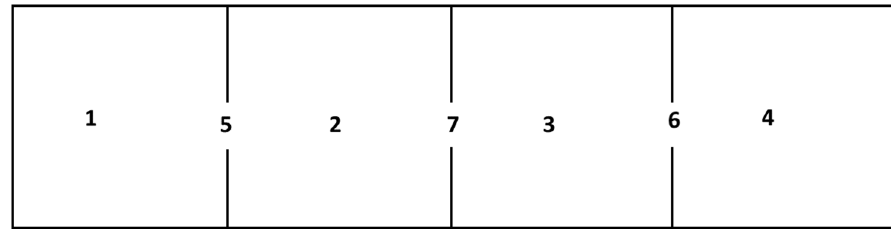
Figure 5. Compaction plane of mud bricks.